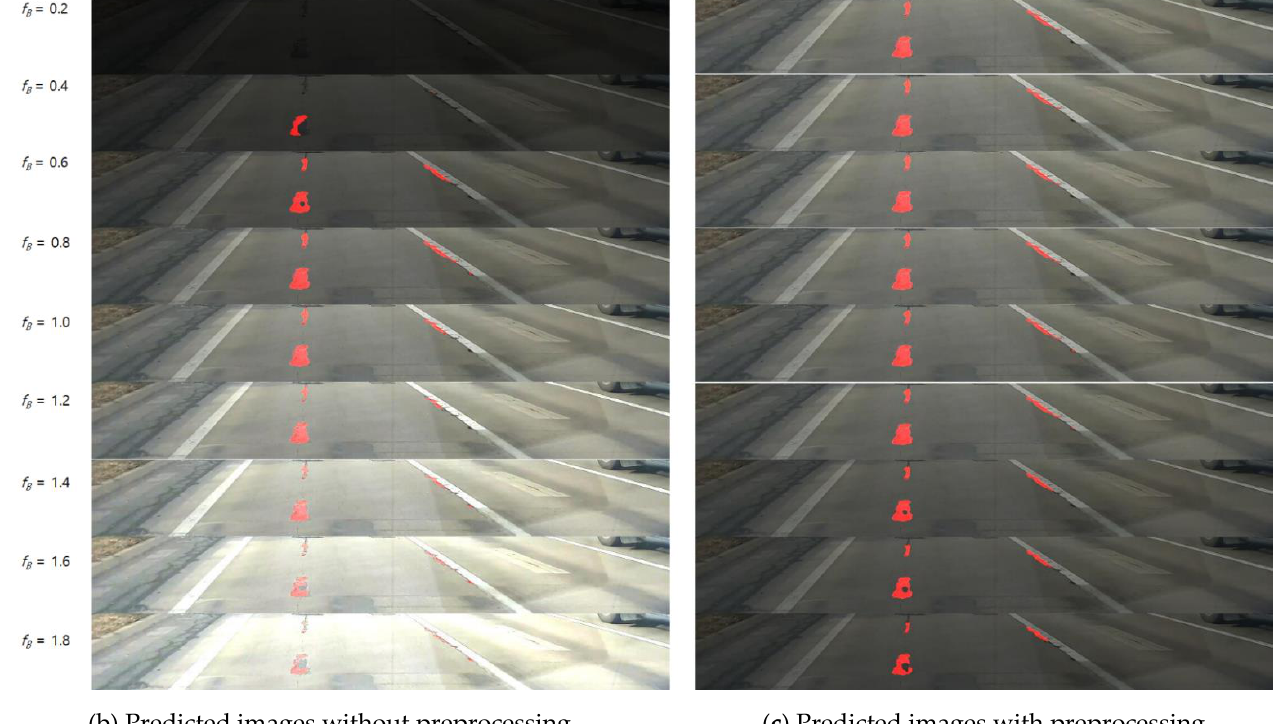
(b) Predicted images without preprocessing. ( c ) Predicted images with preprocessing. Figure 9. Predicted images with and without the image preprocessing model.